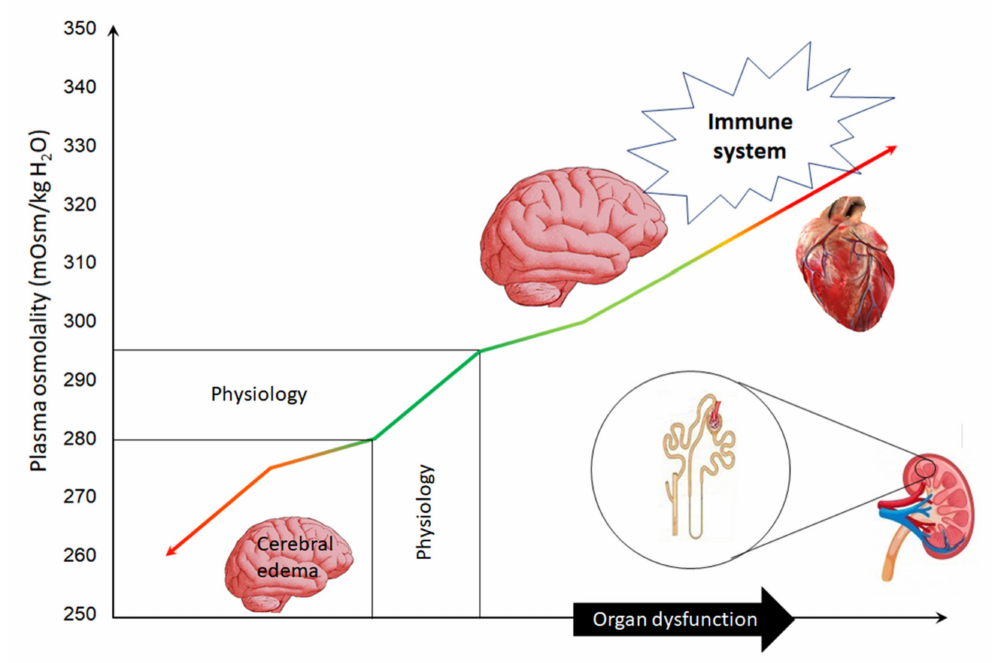
Figure 1. General scheme showing the organs that can be damaged as a result of increased plasma